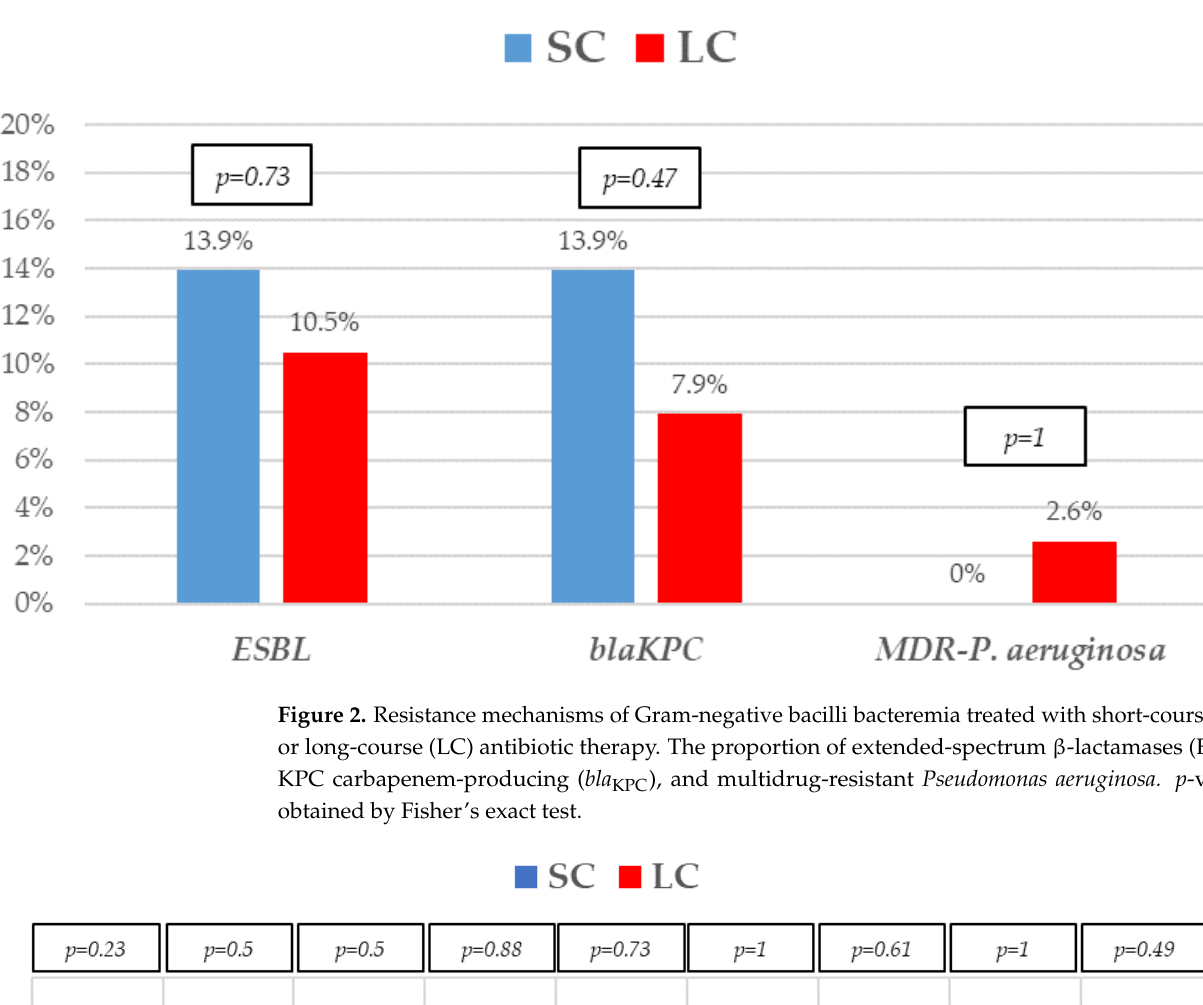
Figure 1. Etiology of Gram-negative bacilli bacteremia treated with a short course (SC) or long course (LC) of antibiotic therapy. p -values obtained by chi-square or Fisher ’ s exact test.